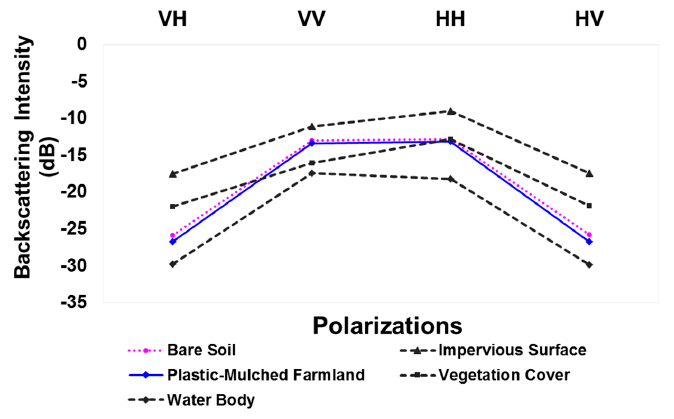
Figure 4. The backscattering intensity of land cover types on Radarsat-2 images in Jizhou.